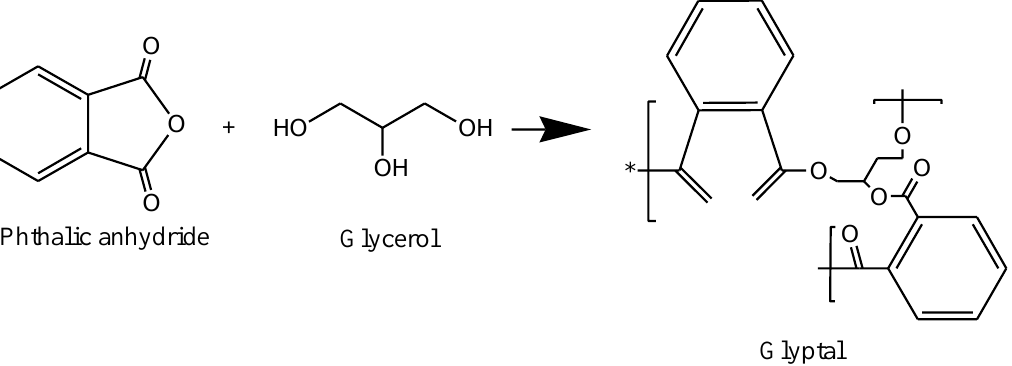
Figure 11 . The reaction of bisphenol A and methacrylic acid with maleic anhydride as a catalyst at a temperature between 90-120°C to form a vinyl ester resin. Vinyl esters are sometimes classified as a polyester but they are di-esters due to the backbone of the chain that contains a link of ether groups [83]. The crosslinking is similar to that of UPs; however, the physical properties are superior due to the presence of olefin groups in the polymer chain [84]. The excellent properties of vinyl esters include good mechanical strength and resistance to chemical, solvent, and corrosion attacks [85].